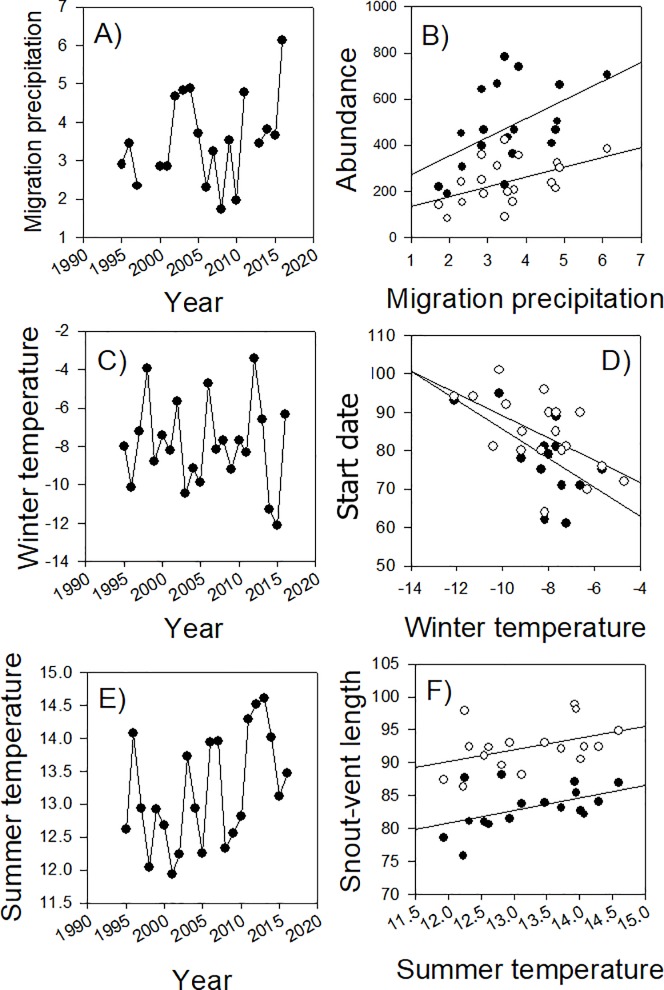
Trends and relationships between seasonal climatic variables and salamander population characteristics.Annual variation in winter-spring transition precipitation (A), minimum winter temperatures (C), and minimum summer temperatures (E). Variation in the total numbers of male (closed circles) and female (open circle) salamander migrants as a function of migration period precipitation (B). The migration start date for male (closed circles) and female (open circles) salamanders based on the 95th percentile arrival day of year (DOY) as a function of minimum previous winter temperature (D). Male (closed circles) and female (open circles) snout-vent lengths (SVL) as a function of minimum previous summer temperatures (F).